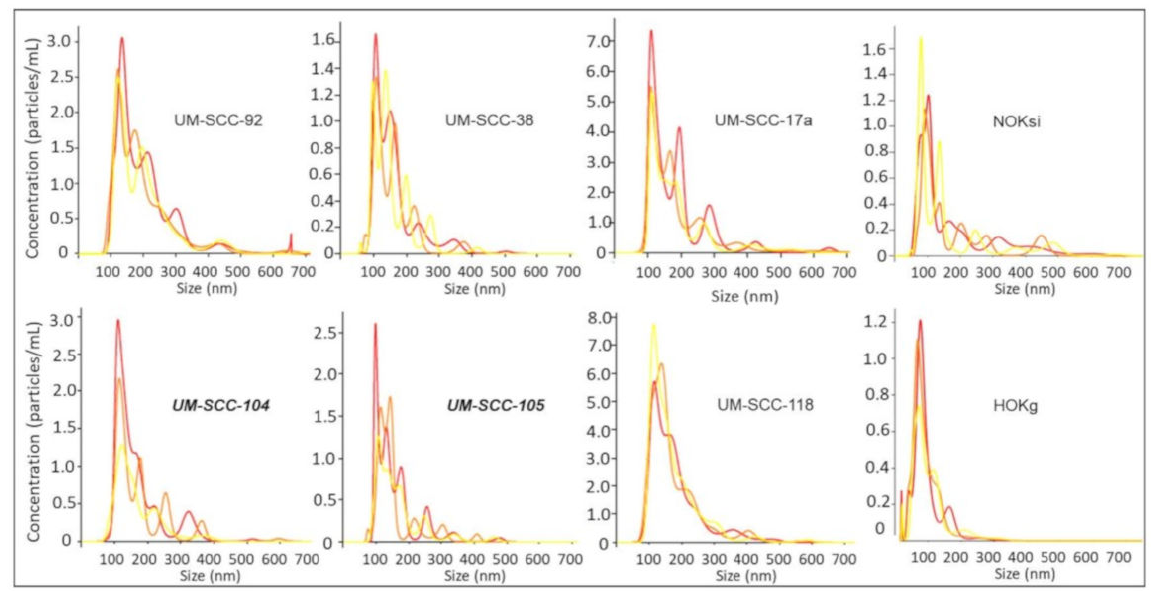
Figure 2. Nanoparticle tracking analysis, showing size and concentration for EVs from six representative HNSCC cell lines and two non-cancer cell lines measured. Bold italics: HPV-positive.